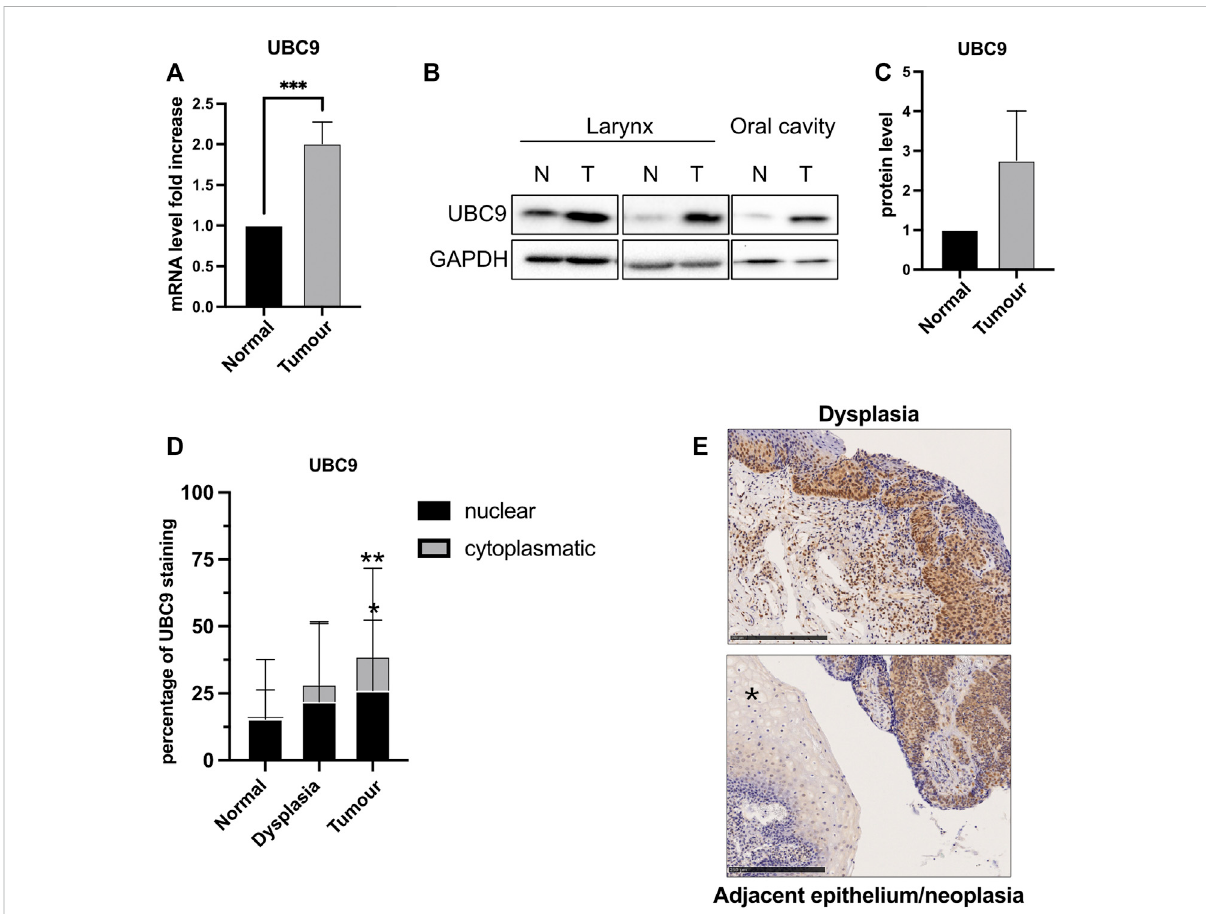
FIGURE 1 Analysis of UBC9 expression in normal and tumoral HNC tissues. (A) Total RNAs from frozen tissue samples of HNC patients (eight HPV- negative and four HPV-positive) were isolated for RT-qPCR and UBC9 expression which were reported as means ± SEM of fold changes. ***, p < 0.001(unpaired t test). (B) ProteinfractionwasextractedfromfrozentissuesamplesofHPV-negativeHNCpatientsandanalyzedbyimmunoblotting with the indicated antibodies. (C) Graph showing means ± SEM of optical density analysis from immunoblotting of UBC9 expressionfrom eight frozen HNC tissue samples. (D) Percentage of UBC9 positivity in nucleus and cytoplasm in dysplastic, tumoral, and matched adjacent mucosa OPC specimens; *, p < 0.05, **, p < 0.01 (two-way ANOVA multiple comparison test). n = 105 (tumor, 56 HPV-negative and 49 HPV-positive), n = 36 (dysplasia,21HPV-negative,and15HPV-positive), n =124(adjacentmucosa,84HPV-negative,and40HPV-positive). (E) RepresentativeIHCimages of FFPE stained with anti-UBC9 antibody from normal (*) and neoplastic OPC tissues (right side of the image) and from high-grade dysplasia, as indicated. Scale bars = 250 μ